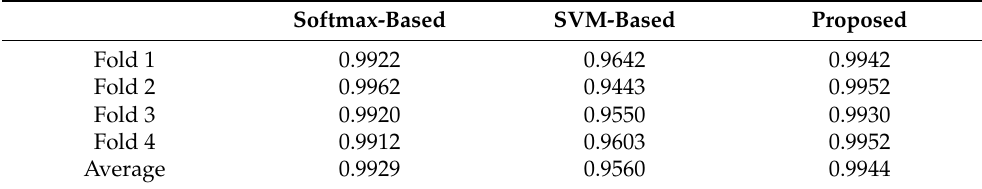
Table 2. Cross-validation accuracy of the three transfer learning models on colon and lung can- cer